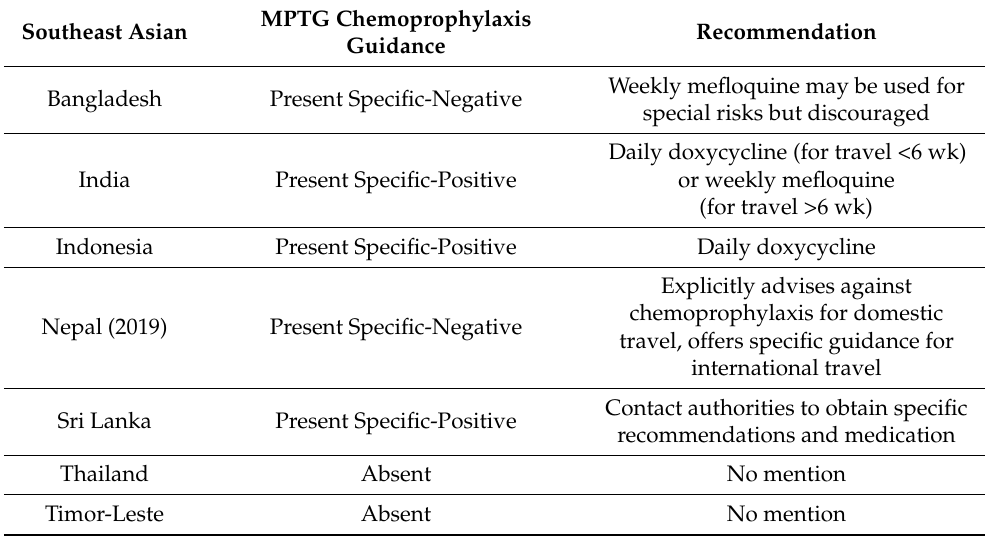
Table 6. Survey Results for Southeast Asia Region.